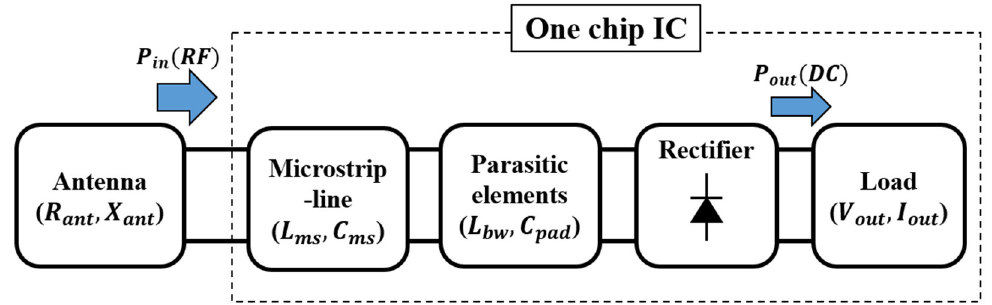
Figure 1. Block diagram of rectenna circuit for MWPT.